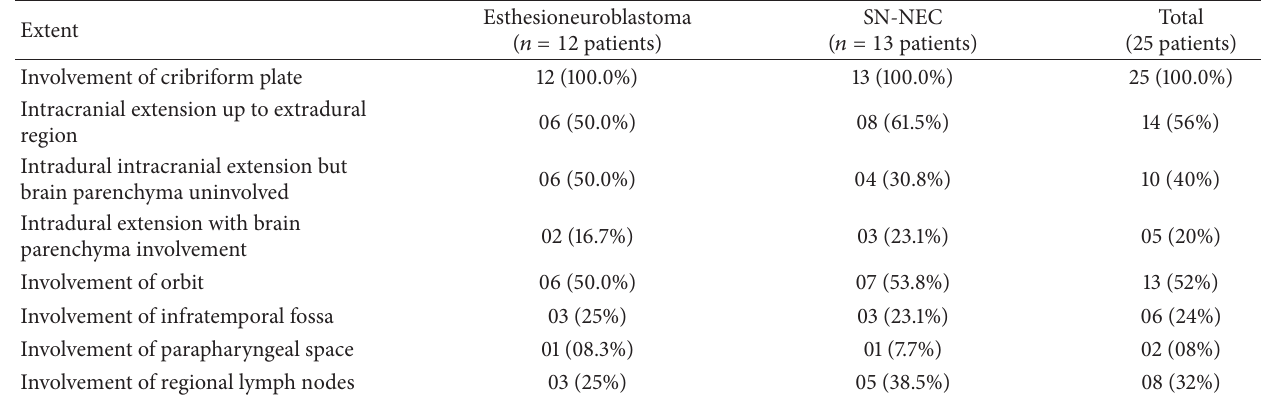
Table 2: Extent of locoregional